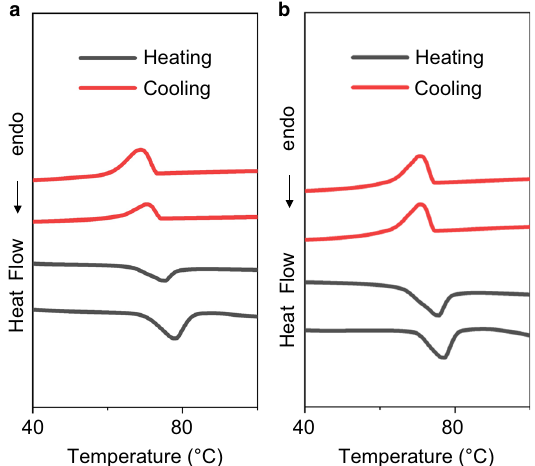
Fig. 8 Phase-transition characteristics of Cu 1.93 S NCs prepared by post- synthetic air oxidation. DSC thermograms of a Cu 1.97 S NCs synthesized by hot-injection and b Cu 1.93 S NCs obtained from post-synthetic air exposure of Cu 1.97 S NCs for 12 h. In each case, thermograms from two heating – cooling cycles performed on the same sample of NCs are shown, from which the reproducibility of the phase-transition peaks (dips) is evident. The thermograms are vertically offset for stacking. The peak temperature of the phase-transition in the heating sub-cycle was averaged across the two cycles to yield T c . Note this study was performed on a different batch of NCs compared to the one in Fig.